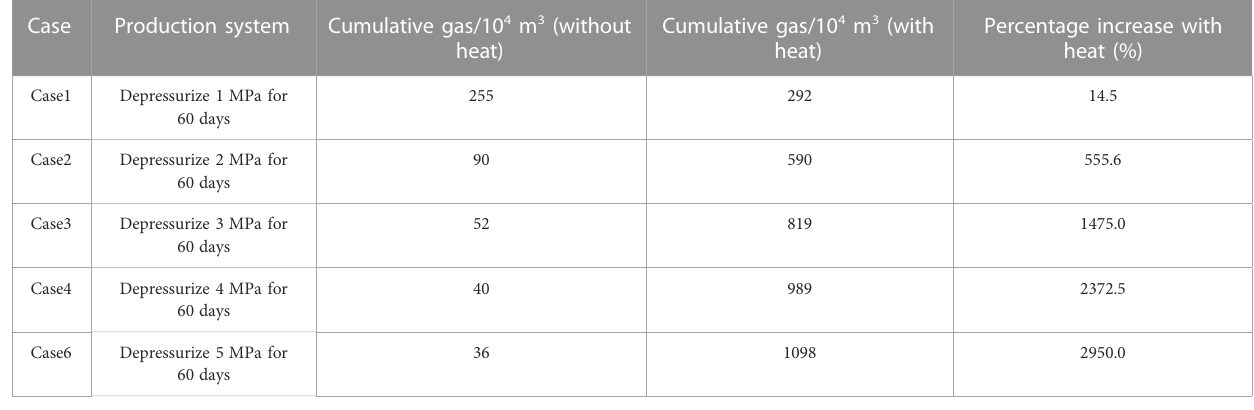
TABLE 7 Analysis of gas production under different production